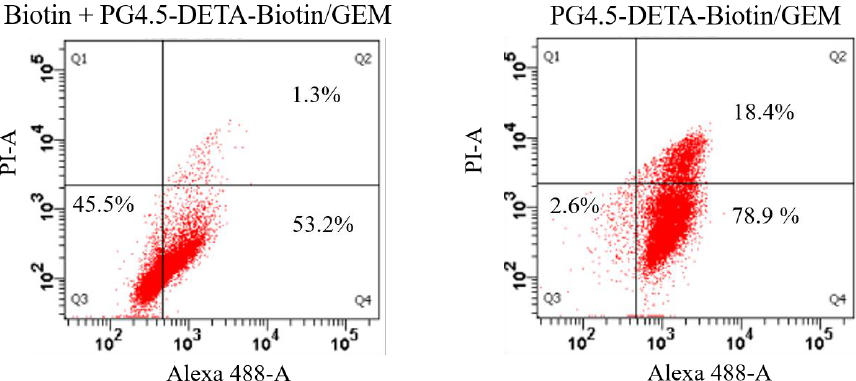
Figure 7. FACS analysis of apoptosis in HeLa cells treated with PBS as a control, free GEM, biotin +